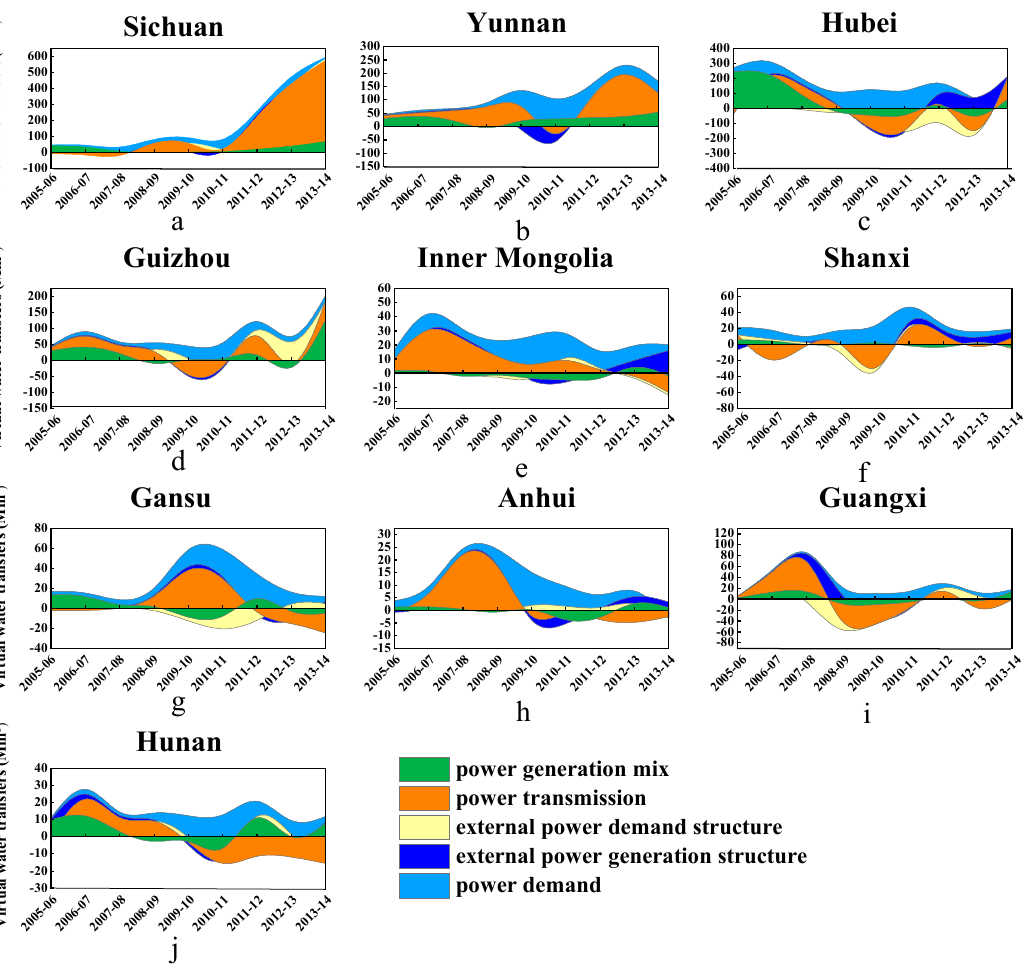
Figure 7. ( a – j ) The contribution of driving factors to the change of virtual water transmission in the top ten virtual water exporters in 2014.